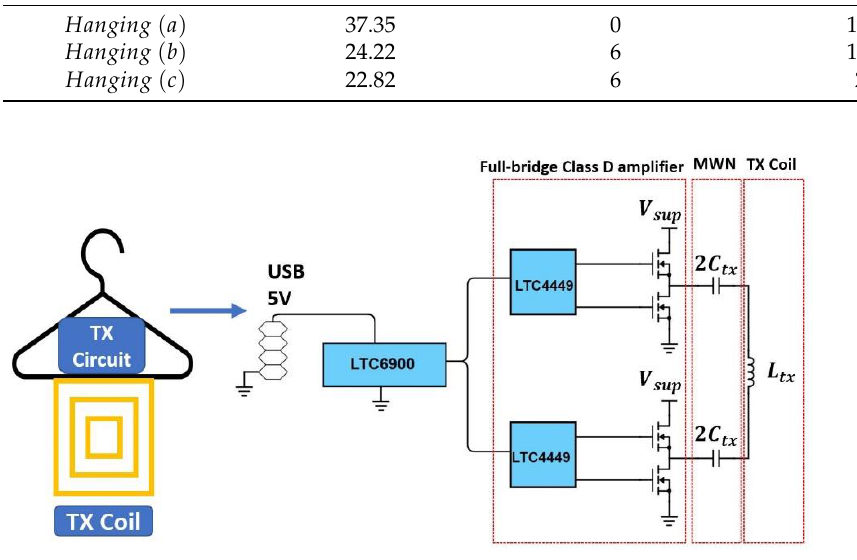
Figure 8. System implementation and schematic of the wireless-charging hanger.